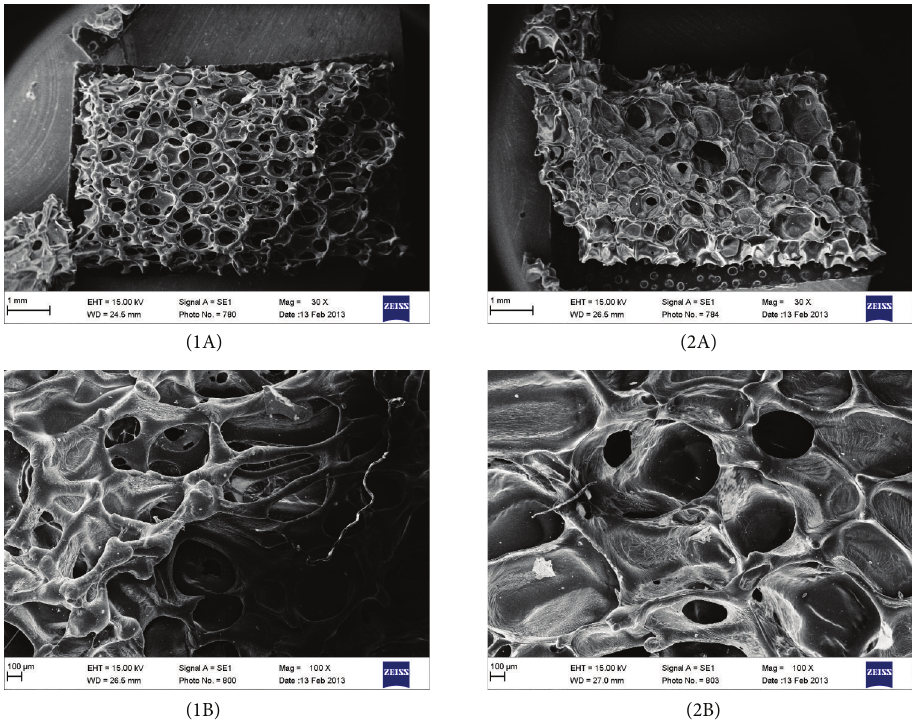
Figure 5: SEM of PU foams, in which chain extender was BDO, after gelatin modification with 20% of gelatin addition, viewed at × 30 (1A) and × 100 (1B) magnification, and 30% of gelatin addition, viewed at × 30 (2A) and × 100 (2B)